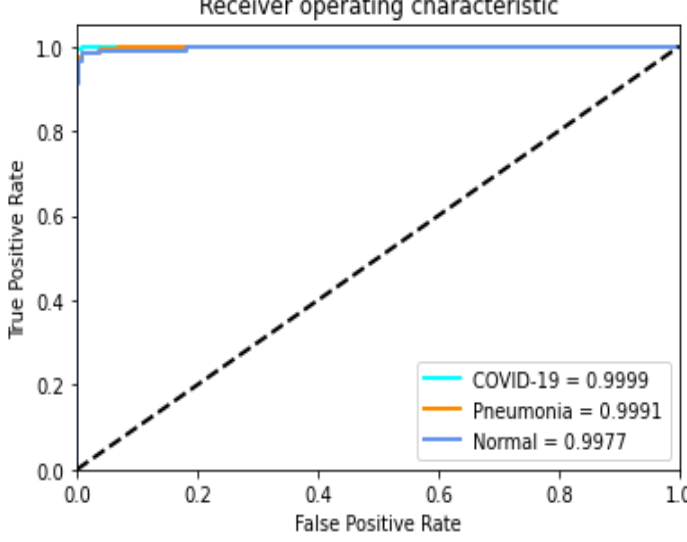
Figure 8. ROC curve of our proposed model for the test